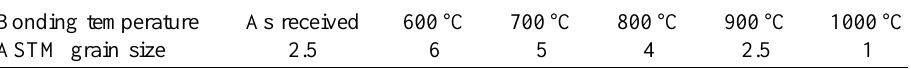
ASTM grain size number of samples bonded at different temperatures.